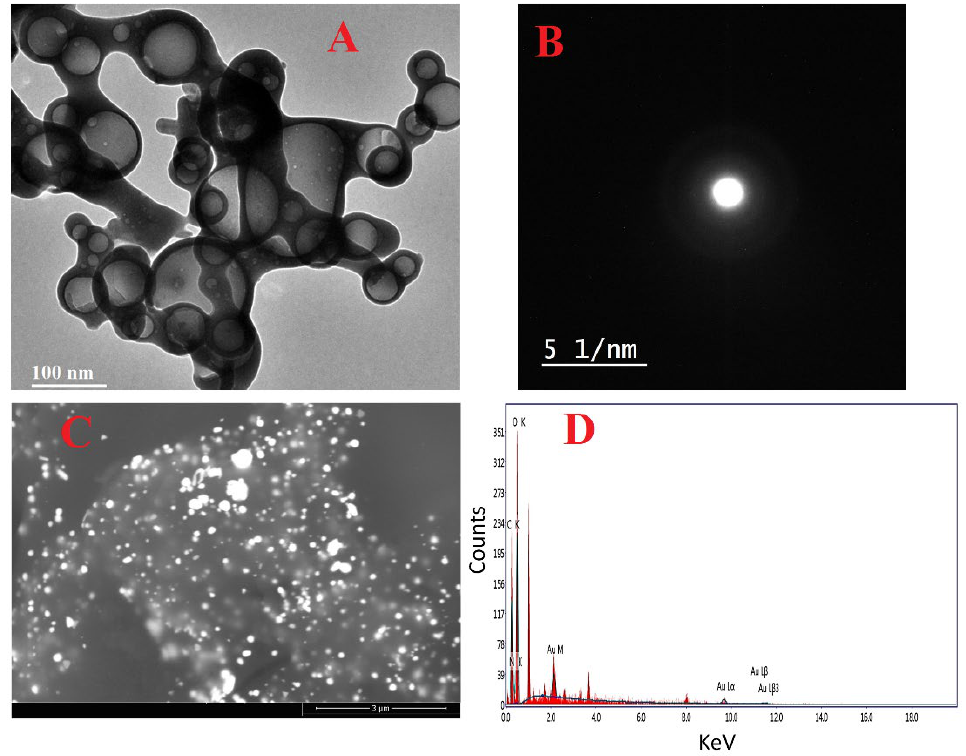
Figure 1. TEM images ( A ), SAED pattern ( B ), SEM image ( C ), and ( D ) EDX spectrum of